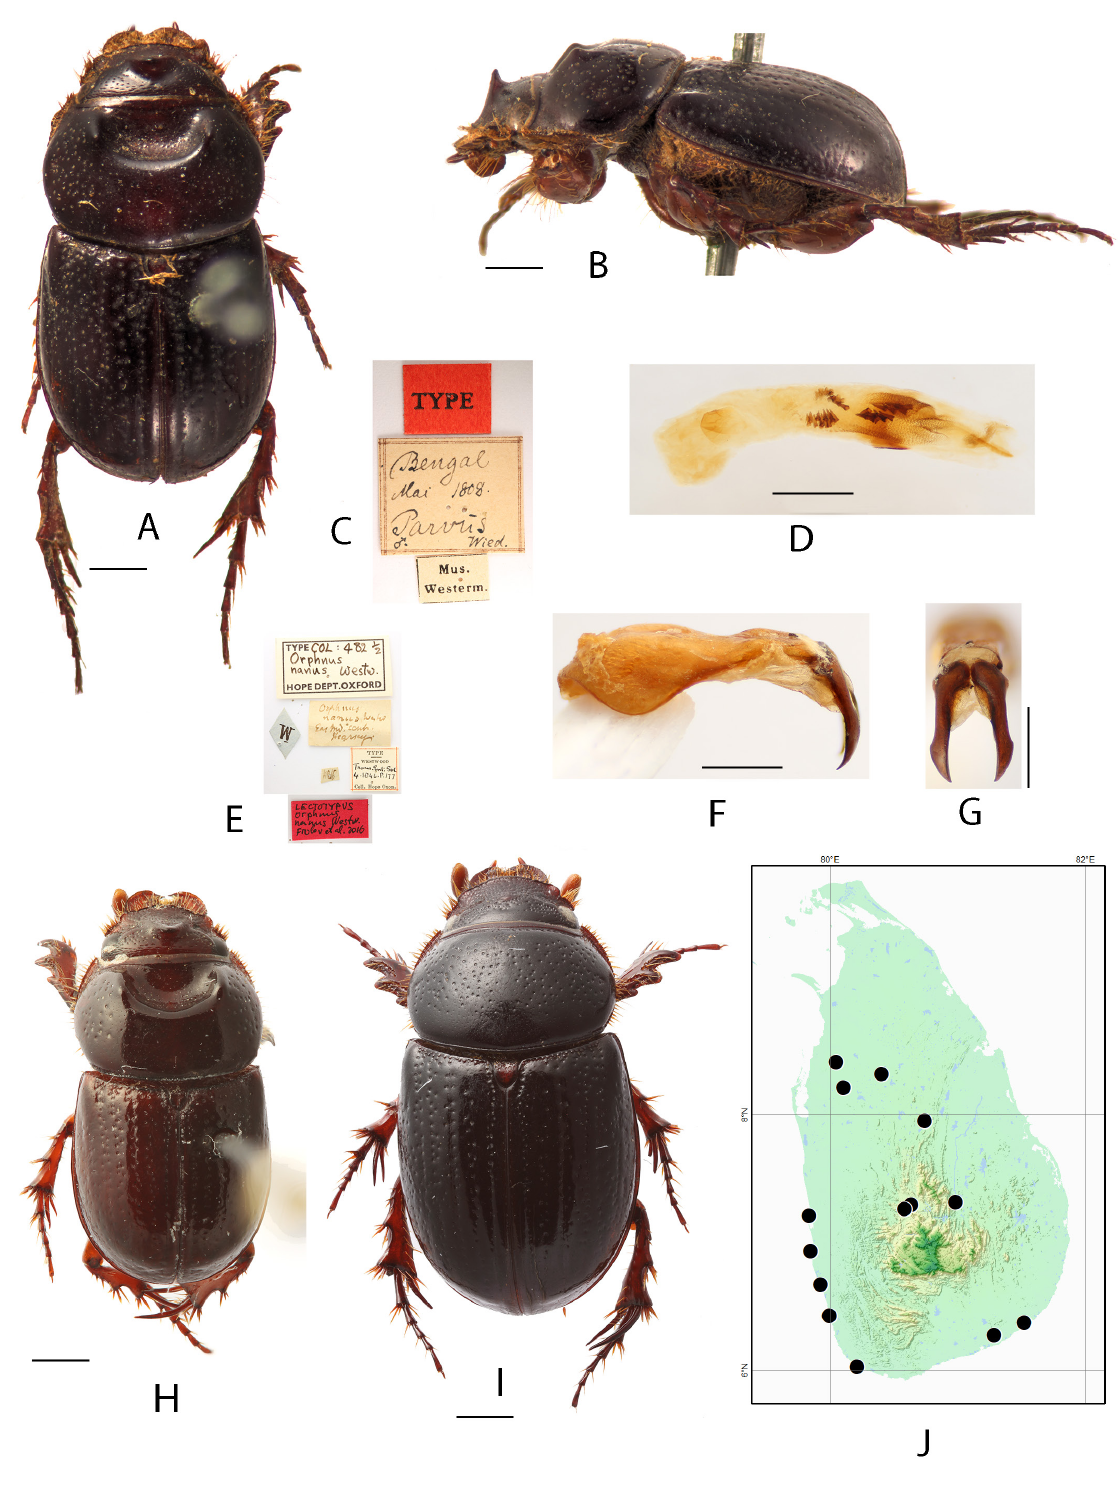
Fig. 5. Orphnus parvus (Wiedemann, 1823). A–C . Lectotype, ♂ (ZMUKK). D–H . Lectotype of Orphnus nanus Westwood, 1845, ♂ (ZMUKK). I . ♀ (MNHN). A–B, H–I . Habitus in dorsal view. C , E . Labels. D . Endophallus. F . Aedeagus in lateral view. G . Parameres in dorsal view. J . Distributional record map. Scale bars: A–B, H–I = 1.0 mm; D, F–G = 0.5